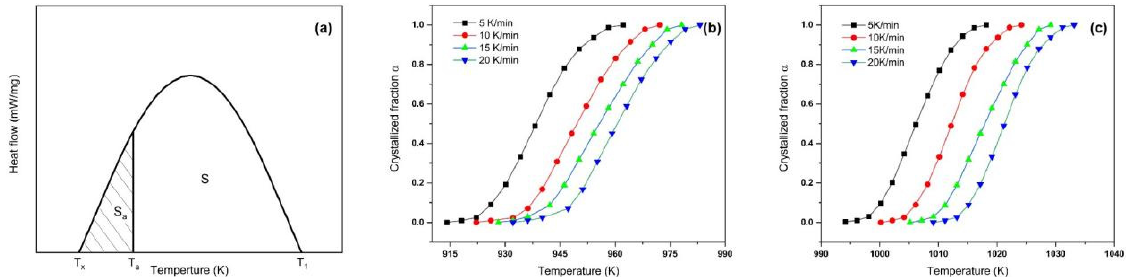
Figure 3. ( a ) Schematic diagram of the determination of the volume fraction of the crystalline phase transition; ( b , c ) variation of crystal integral number under different heating rates of the first and second crystallization peaks.